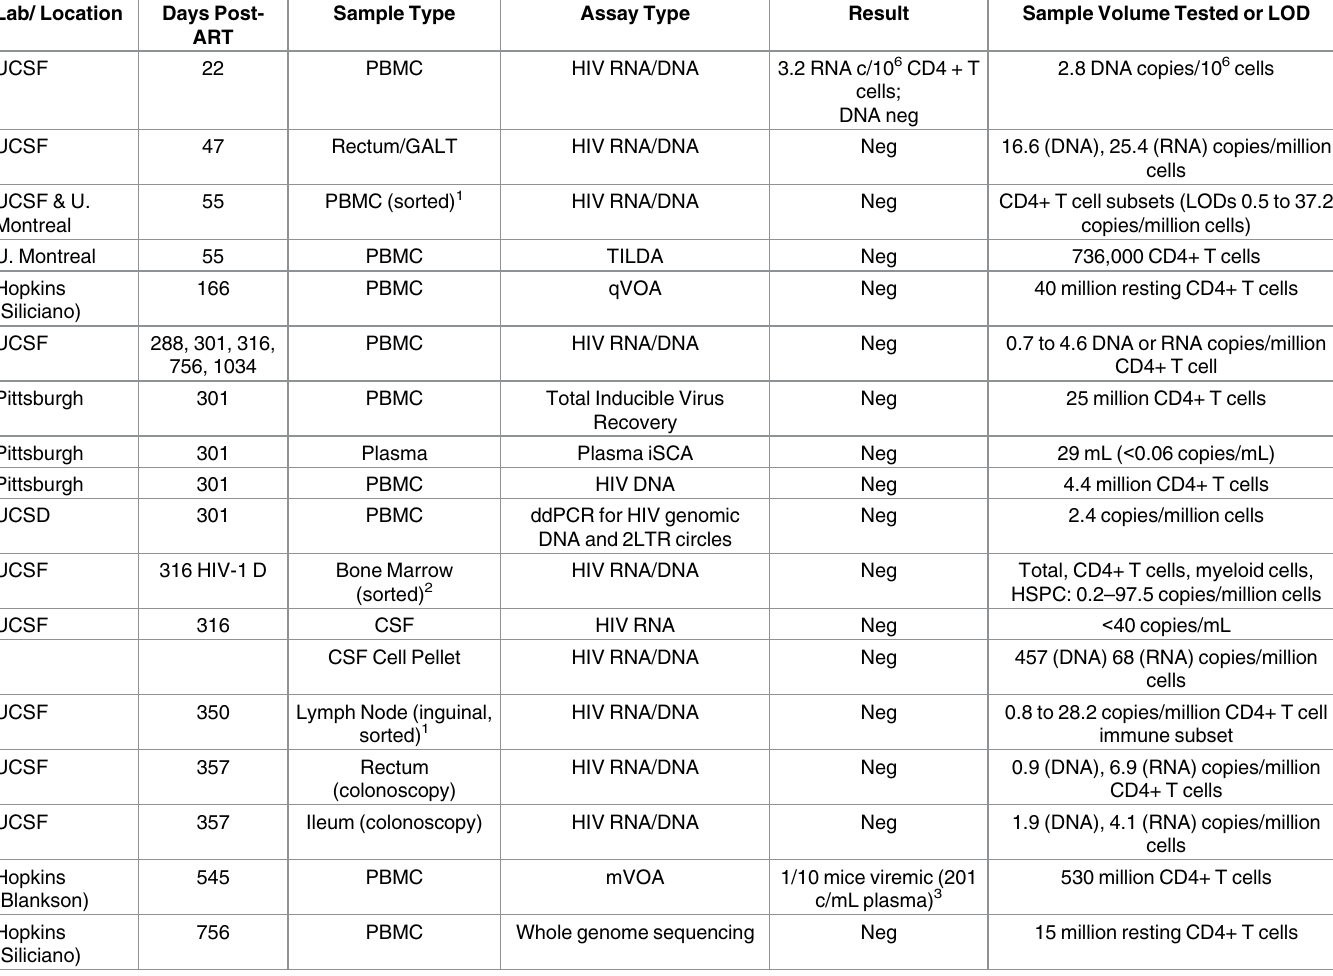
1 DNA and RNA obtained from sorted CD4+ T cell immune subsets (T N , T CM , T EM , and T TM ). 2 DNA and RNA obtained from sorted CD4+ T cells, common lymphoid progenitor cells, hematopoietic stem/progenitor cells, and myeloid cells. 3 Unable to verify result. Abbreviations: ART, antiretroviral therapy; ATI, analytical treatment interruption; c/mL, copies/mL; CSF, cerebrospinal fluid; ddPCR, droplet digital PCR; GALT, gut-associated lymphoid tissue; HSPC, hematopoietic stem and progenitor cells; iSCA, integrase single copy assay; LOD, limit of detection;